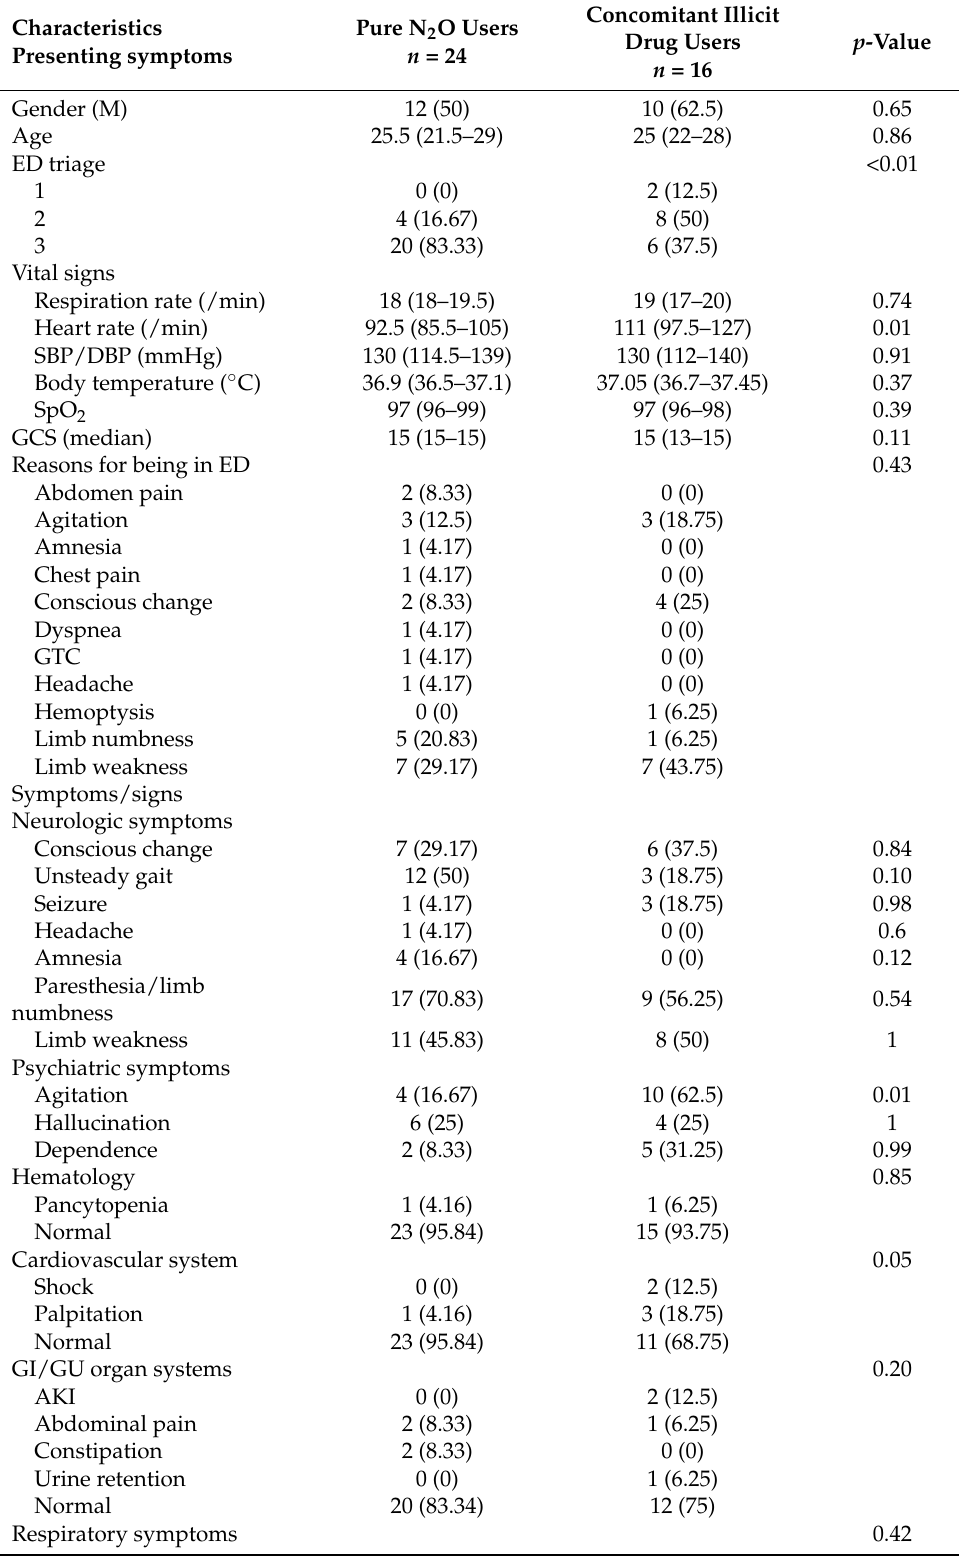
Table 1. Demographic characteristics of ED patients intentionally using N 2